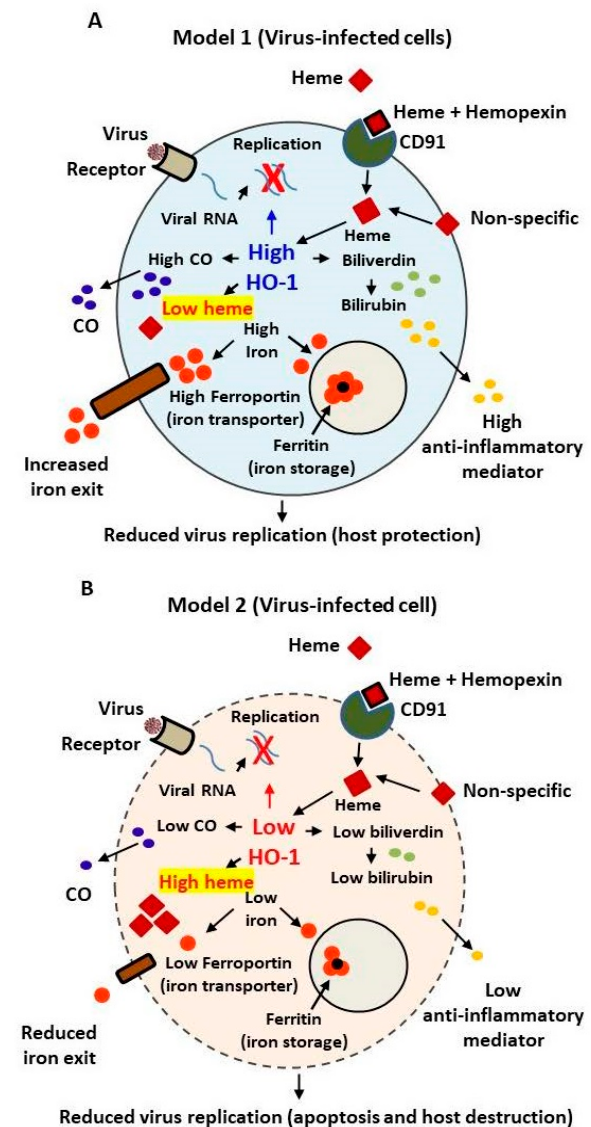
Figure 2. Models depicting the involvement of HO-1-dependent innate cellular resistance to viruses by reducing virus replication and host protection ( A ) or host destruction by heme cytotoxicity ( B ). Interventions involving activation of the powerful cellular HO-1-dependent cellular response by its natural substrate hemin could enable additional a safe viable option for reducing the severity of infections and disease progression. Therefore, HO-1-depenent strong resistance to various viruses for blocking or limiting their replication and associ- ated pathogenesis should be explored to gain additional insights for mitigating SARS- CoV-2 infection . Scientific studies on evaluating the role of inducing HO-1 should provide an effective and productive outcome in advancing new therapeutic options. Modulation of the innate HO-1 may pave ways to provide new key insights into dis- rupting the replication cycle between the viruses and host factors for an alternative or concurrent effective physiological therapeutic strategy to effectively ameliorate infections by SARS-CoV-2 or other emerging viral pathogens. Activation of cellular HO-1-depend- ent cellular response could enable additional safe viable option for reducing SARS-CoV-